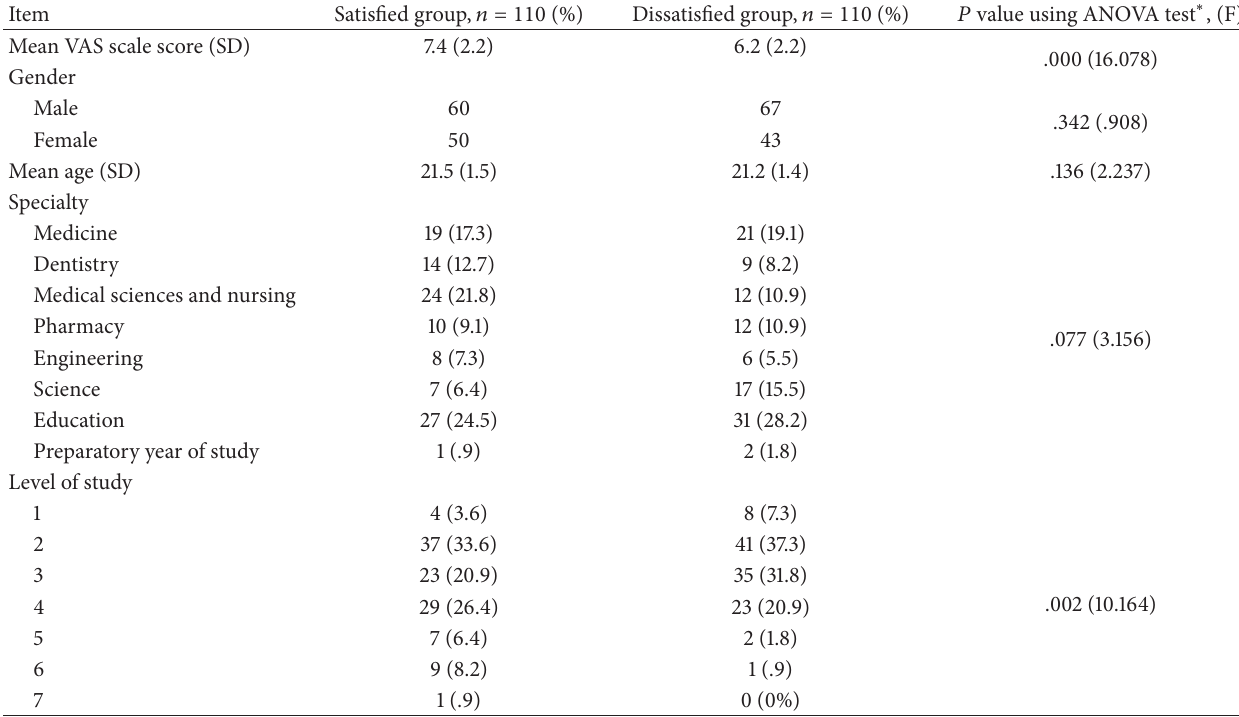
Table 4: Distribution of satisfied ( 𝑛 = 110 ) and dissatisfied ( 𝑛 = 110 ) participants by mean VAS scale score of satisfaction and participants’ sociodemographic